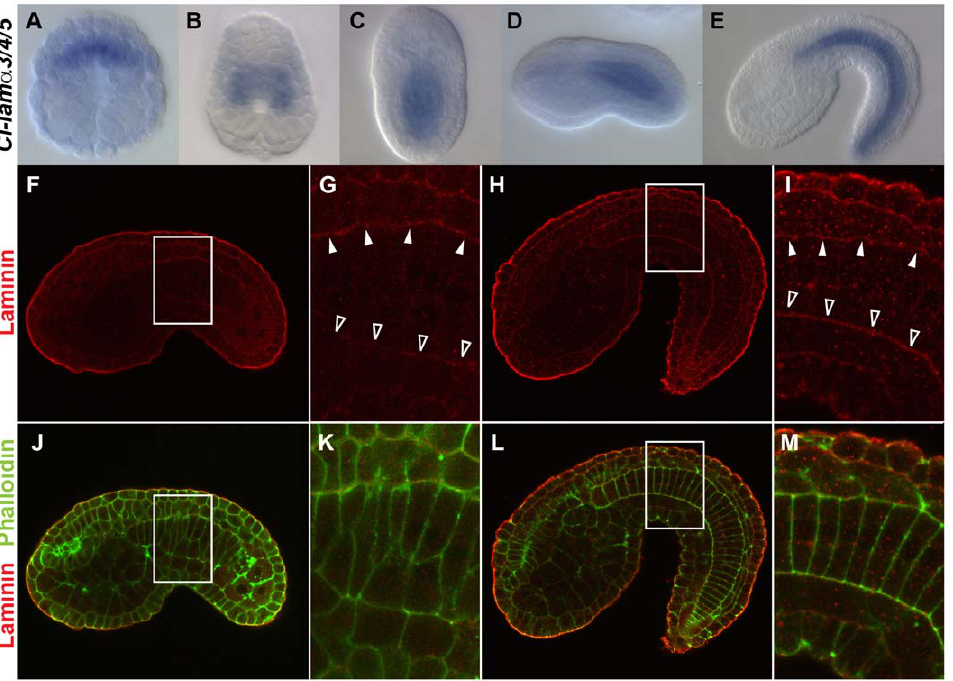
Figure 1. Distribution of laminin in Cionaintestinalis embryos. (A–E) Whole-mount in situ hybridization of early gastrula (A), late gastrula (B), late neurula (C), early tailbud (D) and middle-late tailbud (E) stages for Ci-lam a 3/4/5 mRNA . A is vegetal view, B and C are dorsal views, and D and E are lateral views. Anterior is to the top in A–C and to the left in D and E. Note that Ci-lam a 3/4/5 is preferentially expressed in notochord lineage cells. (F– M) Confocal images of embryos stained with the anti-Cs-lam a 3/4/5 (red) alone (F–I) and double staining with phalloidin (green, J–M) at early tailbud (F,G,J,K) and middle-late tailbud (H,I,L,M) stages. All images are lateral views and anterior is to the left. G, I, K and M are higher magnification of the boxed area in F, H, J and L, respectively. Note: In all cases, high background red signal outlining embryos was seen perhaps due to an edge effect as Cs-lam a 3/4/5 mRNA is undetectable there. At early taulbud stage, a high signal accumulation or maternal laminin protein is detectable at the dorsal side (white arrowheads in G) but not at the ventral side (open arrowheads in G) of the notochord. When intercalation is completed, Cs-lam a 3/4/5 signal expands to the ventral side (open arrowheads in I) of the notochord and asymmetric distribution along the dorsoventral axis is lost (I,M).